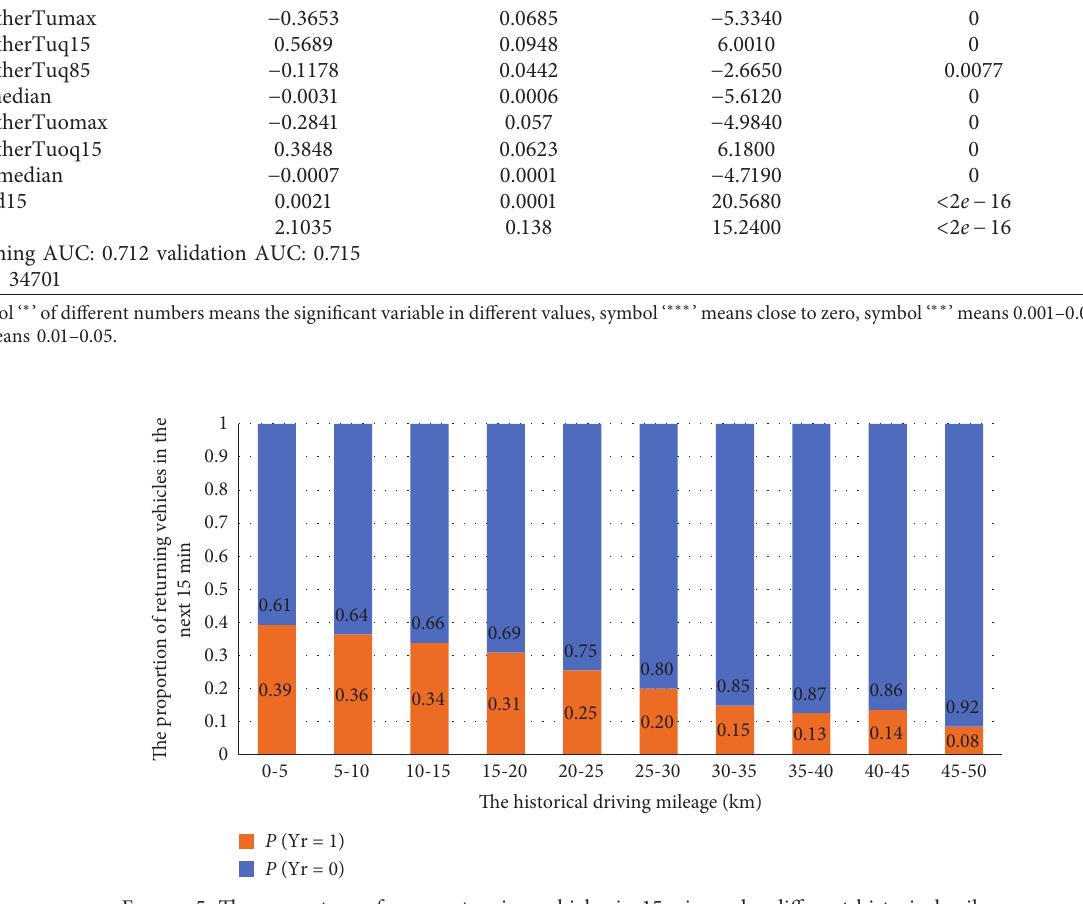
Figure 5: The percentage of users returning vehicles in 15min under different historical